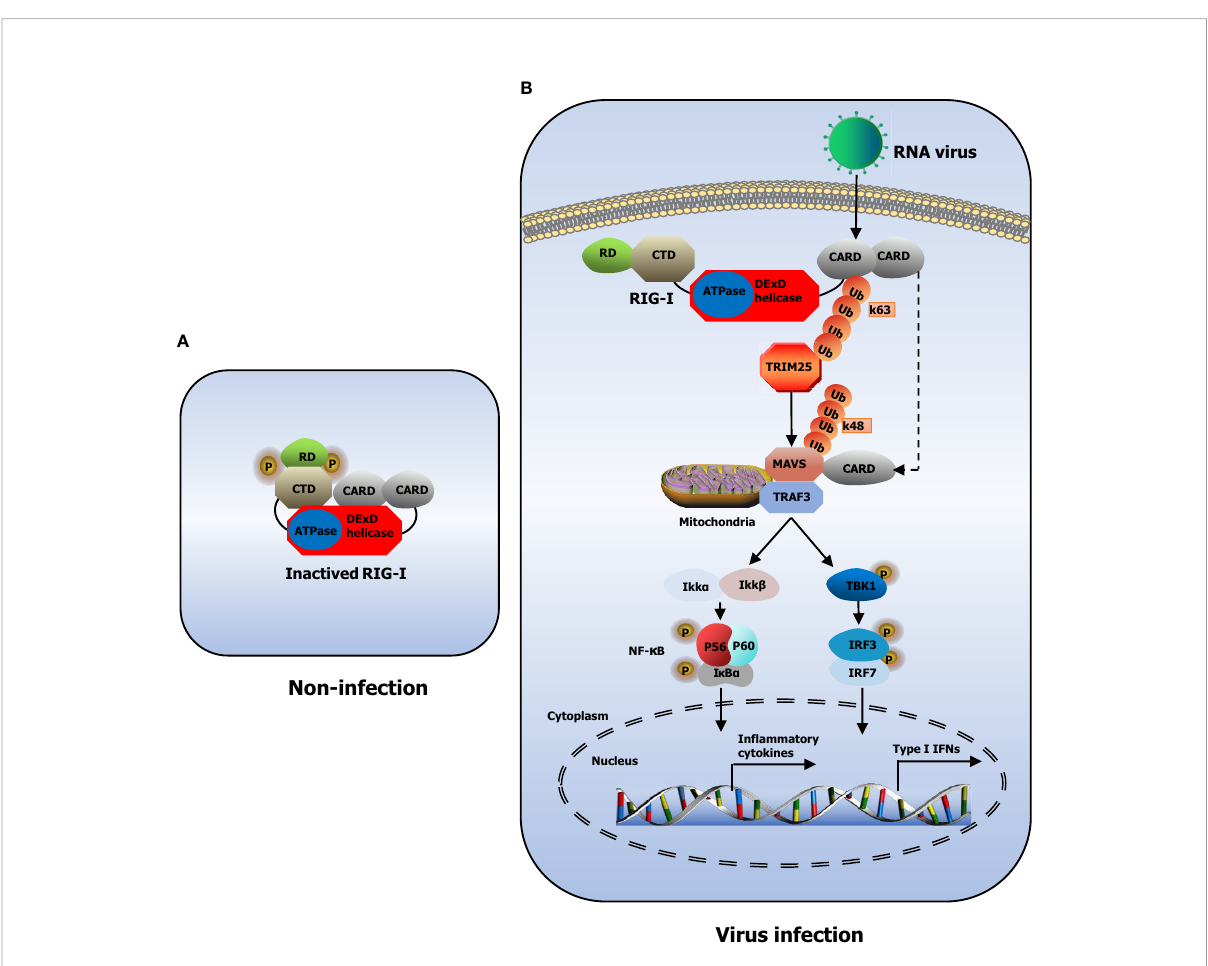
FIGURE 1 Model of RIG-I structure and signaling pathway. (A) The structure of RIG-I in non-infected cells. (B) RIG-I signaling pathway. During RNA virus infection, RIG-I recognizes RNA molecules and undergoes conformational changes that expose and multimerize its CARDs, which allows homotypic CARD – CARD interactions with MAVS. MAVS is anchored into mitochondria and relays the signal to TBK1 and IKK. These in turn activate IRF3 and IRF7, which together with the transcription factor NF- k B induce expression of type I IFNs and in fl ammatory